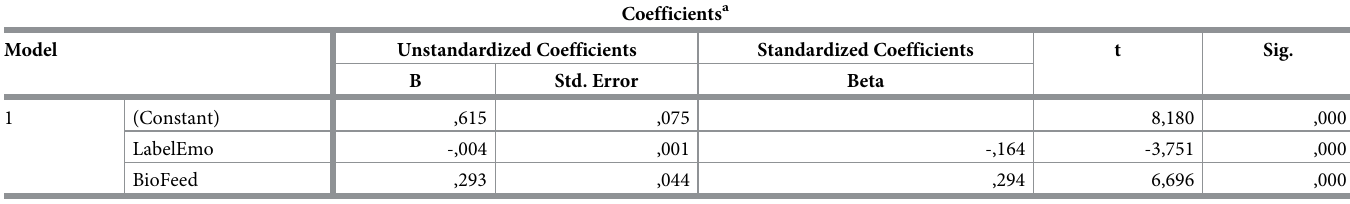
Table 5. Linear regression between biofeedback, test anxiety and